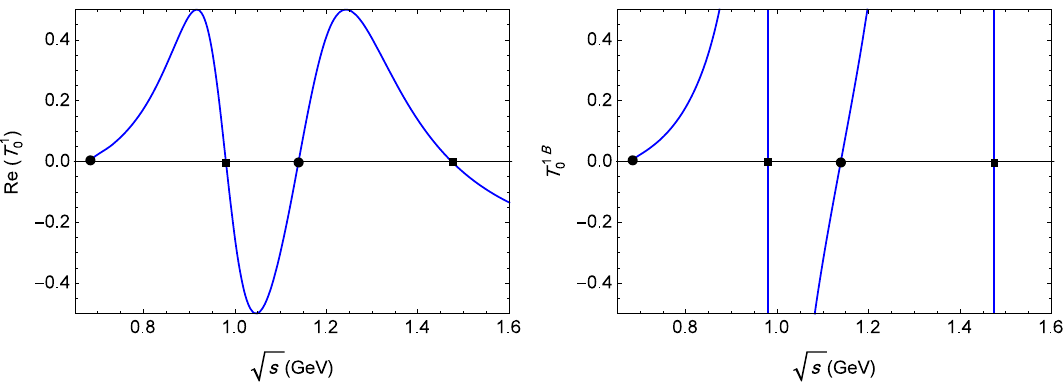
Fig. 6 Real part of the I = 1, J = 0, πη scattering amplitude computed in GLSM. The bare amplitude (left) contains zeros (circles) and poles (squares) at which the unitarized amplitude (right) also vanishes